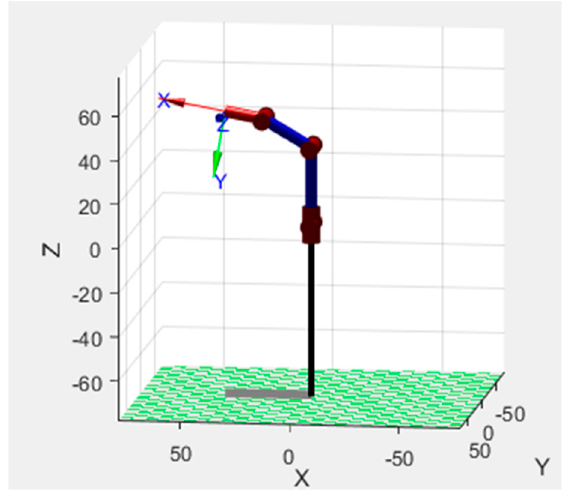
Figure 5. Peter Croke results for the middle finger.